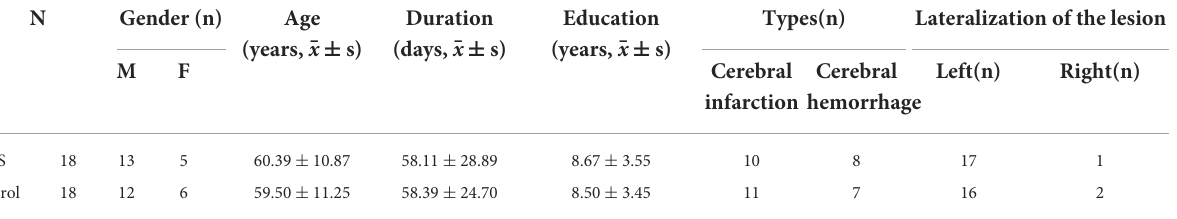
TABLE 1 Comparison of baseline data of two